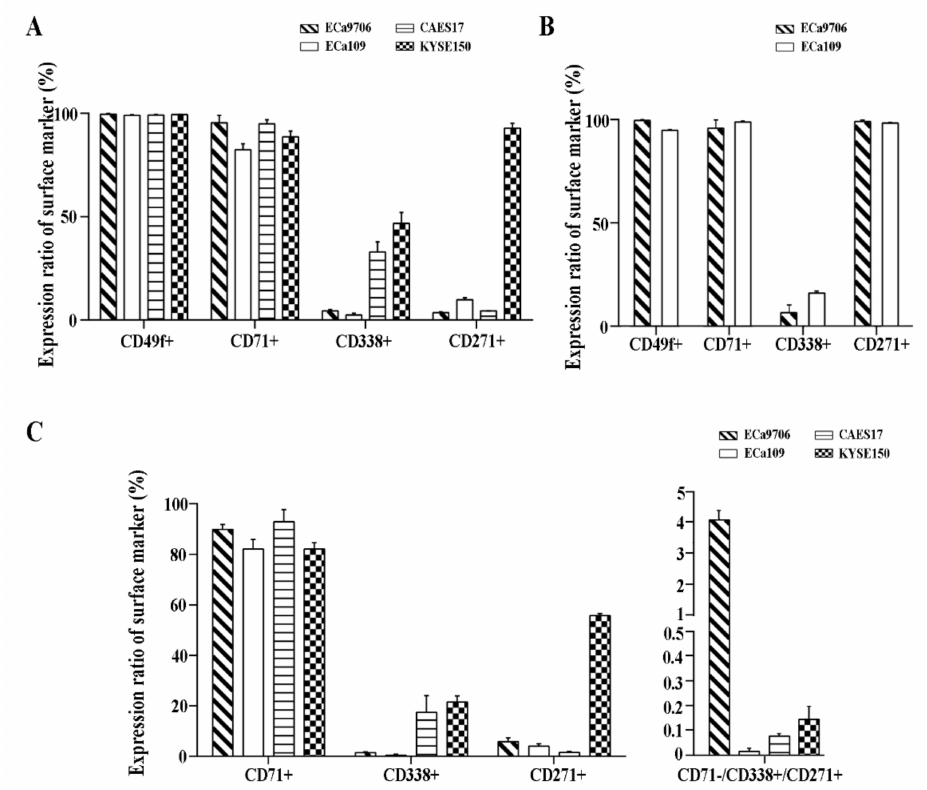
Figure 1. Expression of CD49f, CD71 − , CD271 + , and CD338 + in esophageal squamous cell carcinoma (ESCC). ( A ) Expression ratios of surface markers in di ff erent cell lines. ( B ) Expression ratios of surface markers in cell lines stained with the four surface markers together. ( C ) Expression ratios of CD71, CD271, and CD338 in di ff erent cell